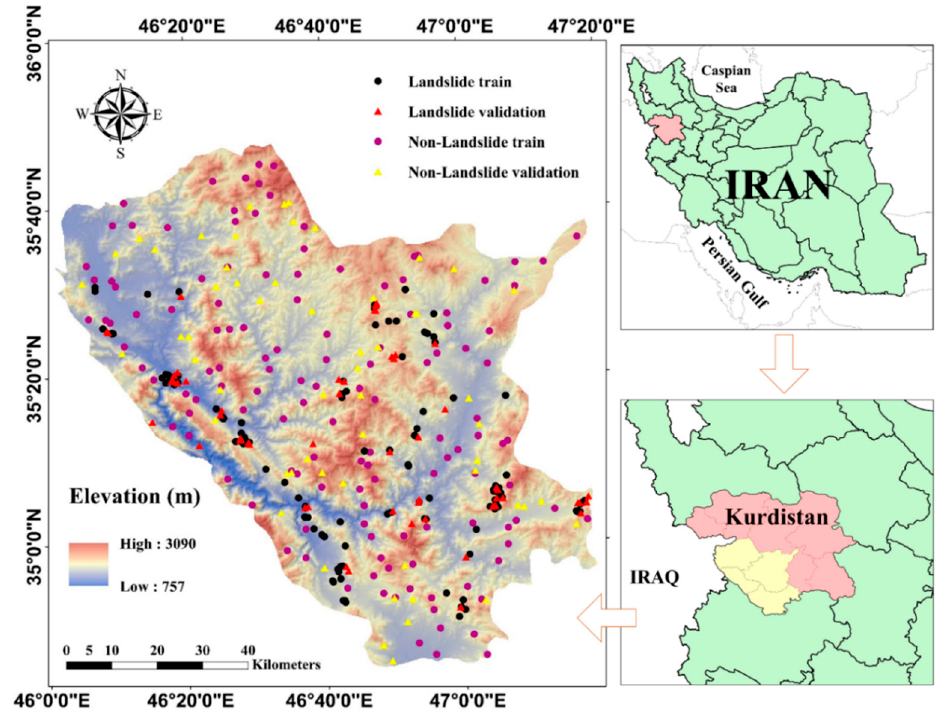
Figure 1. Location of the study area and distribution of the landslides.